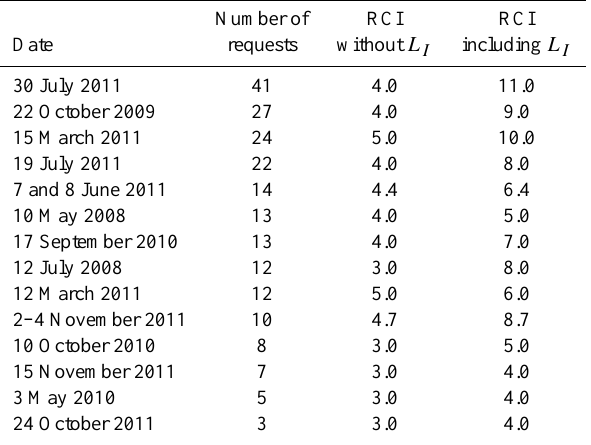
Table 6. Comparison between the RCI calculated without the inten- sity factor and the RCI including it, for the studied events. Popula- tion factor has not been